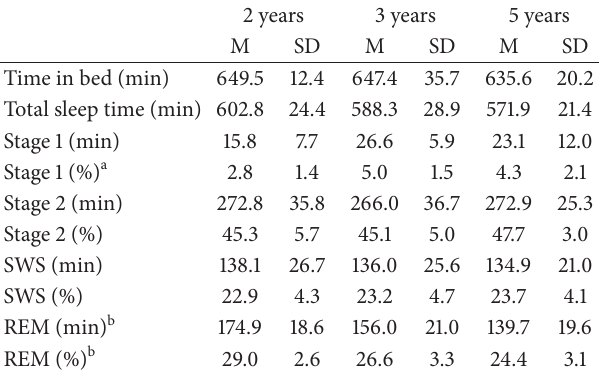
Table 1: Descriptive statistics (M, SD) for sleep stage variables at ages 2, 3, and 5 years for the entire nighttime sleep episode. Significant post hoc paired 𝑡 -tests (2-tailed) are denoted as a (2 years versus 3 years) and b (2 years versus 5